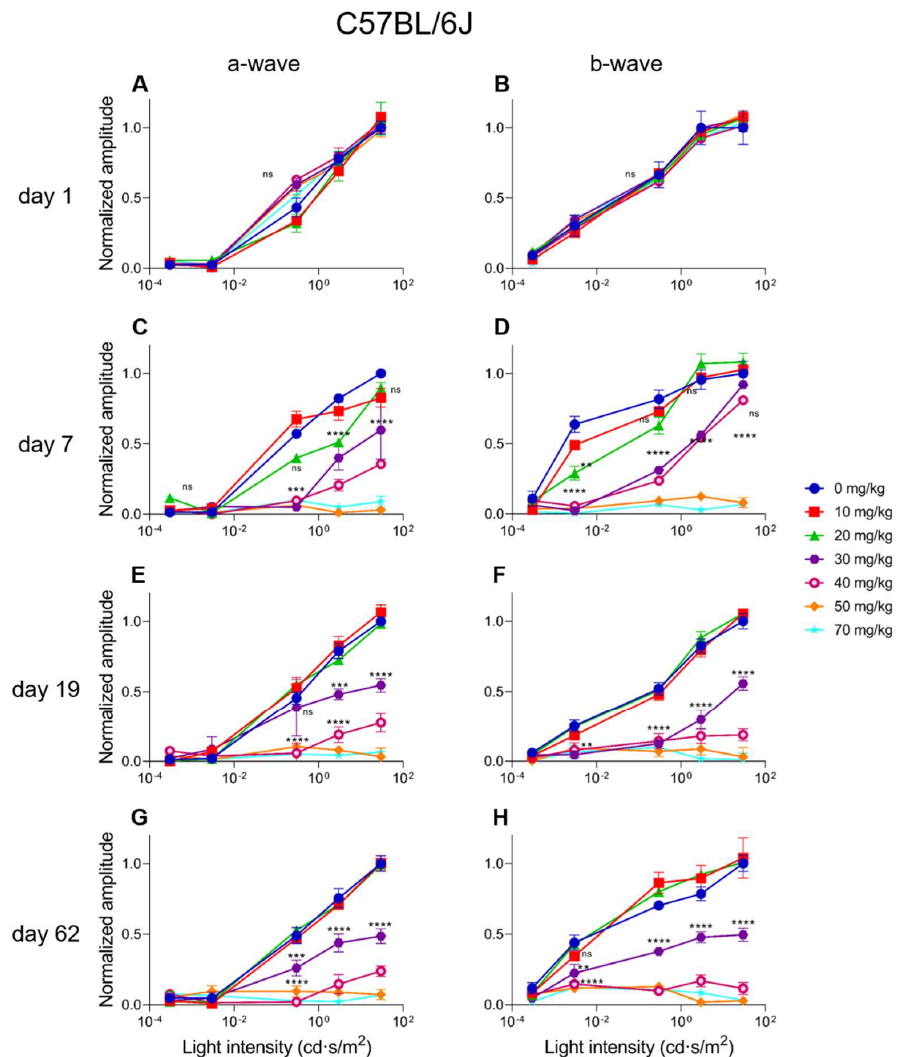
Figure 7. The normalized a-wave ( A , C , E , G ) and b-wave ( B , D , F , H ) amplitudes are plotted versus the light intensity for all the treatment groups in C57BL/6J mice ( n = 4 per group). The amplitudes are shown ± the standard deviations. No significant differences can be observed at day 1 (baseline) between all the treatment groups. The treatment effects started to show from seven-days post-injection onwards. A slight effect was observed for the 20 mg/kg treatment group for both the a- and b-wave. The 30 and 40 mg/kg caused similar and moderate effects, and 50 and 70 mg/kg caused more extreme decreased amplitudes. From day 19 onwards, more long-term effects were visible. No significant differences were observed between the control, 10 mg/kg and 20 mg/kg groups. A significant and moderate effect was observed for the 30 mg/kg treatment group. Injection of 30 mg/kg SI caused a reduction of the a- and b-wave amplitudes of roughly 50% at least up to two-months post-injection. More extreme effects were observed for the higher doses (40, 50 and 70 mg/kg). Reduced responses to 20% to non-recordable ERG responses were observed in these groups. ns : not significant, **: p ≤ 0.01, ***: p ≤ 0.001, and ****: p ≤ 0.0001. A dose-dependent electroretinographic response for SI could also be observed in the Brown Norway rats. A 10 mg/kg SI dose did not cause significant differences compared to the controls (see Figures 8 and 9). A dose of 20 mg/kg caused a significant decrease for